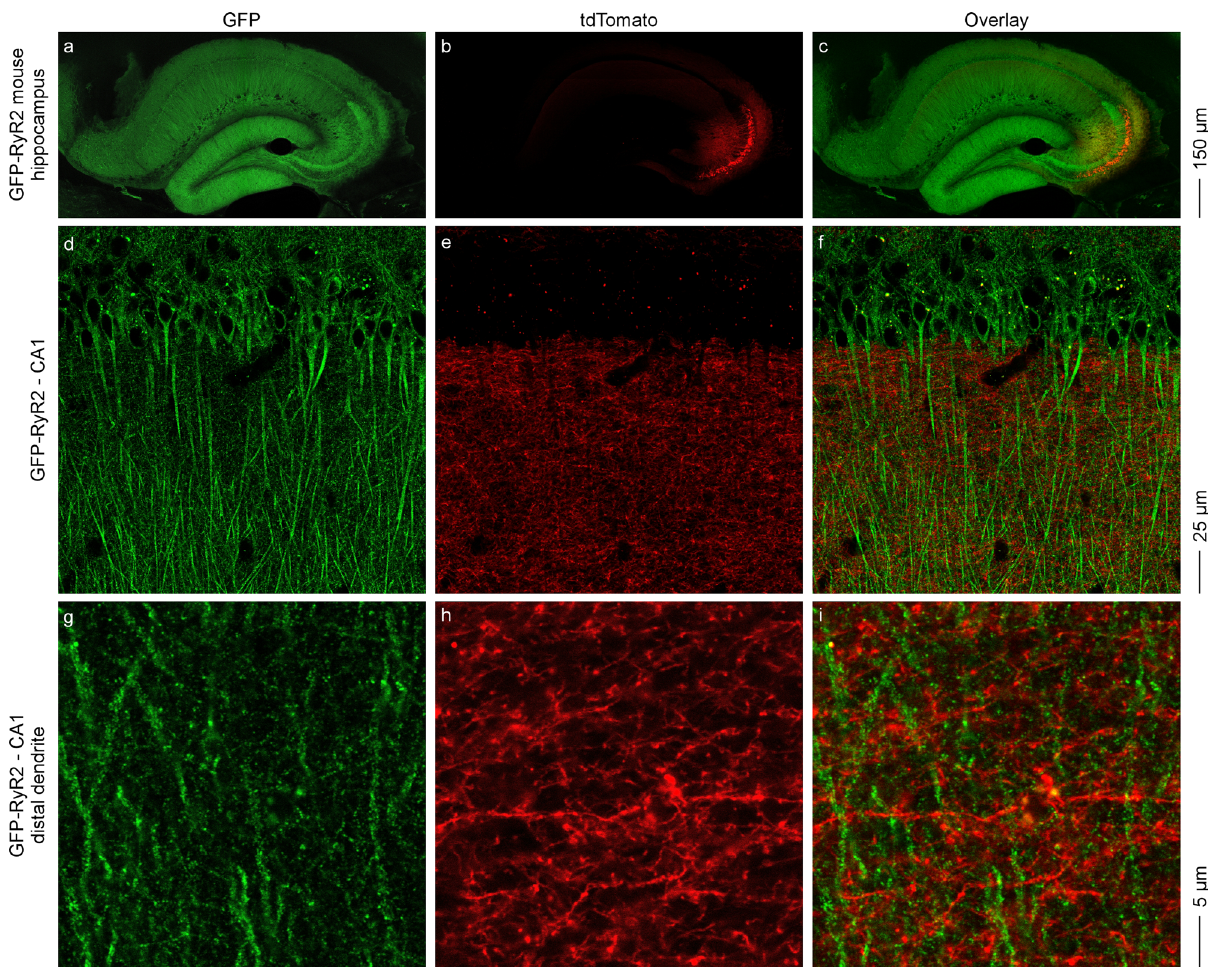
Fig. 4 Confocal imaging of live hippocampal slices from GFP-RyR2 mice with AAV9-tdTomato infected CA3 region. Representative confocal fl uorescence images of live hippocampal slices from mice expressing the GFP-tagged RyR2 with AAV9-tdTomato infected CA3 region ( n = 9 images from three brains). Images of the whole hippocampal area showing the AAV9-tdTomato infected CA3 region ( a – c ). Magni fi ed views showing the CA1 area ( d – f ) and tdTomato- fi lled axons from the CA3 region and distal dendrites of CA1 neurons ( g – i